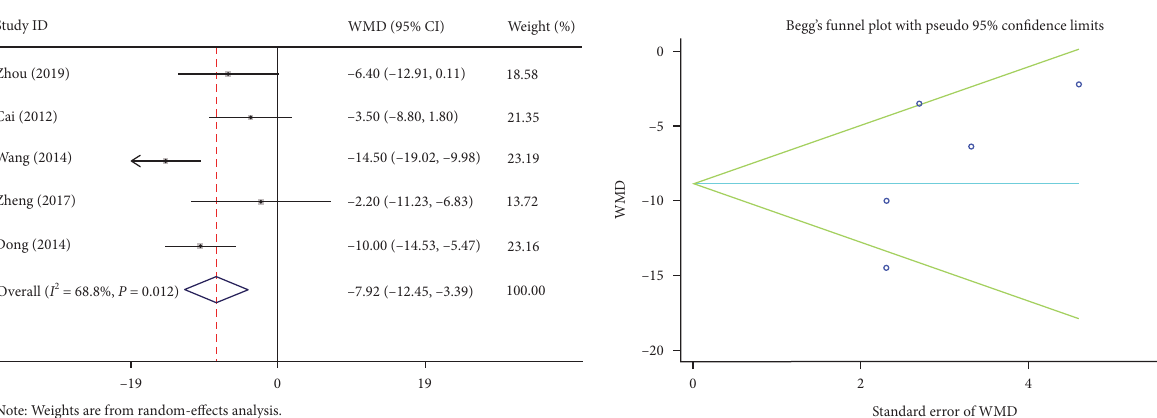
Note: Weights are from random-effects model. F IGURE 2: Forest plot and funnel plot of the operative time between the primary suture group and the T-tube drainage group.